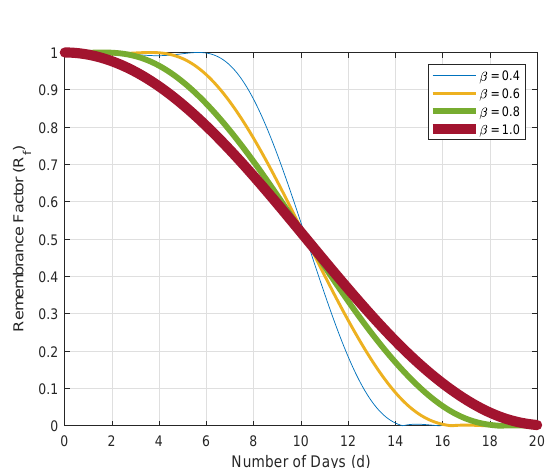
as a function of f days − 1 and with different values of β . 20